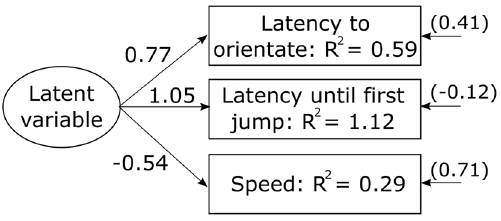
Figure 1. Path diagrams of the structure equation model explaining the covariance structure among the three behaviors assessed during the territorial defense test. R 2 represent the variances of the different behaviors. Numbers associated with arrows represent how behavioral responses are predicted to change based on changes to the latent variable. Number in brackets represent error variances associated to each